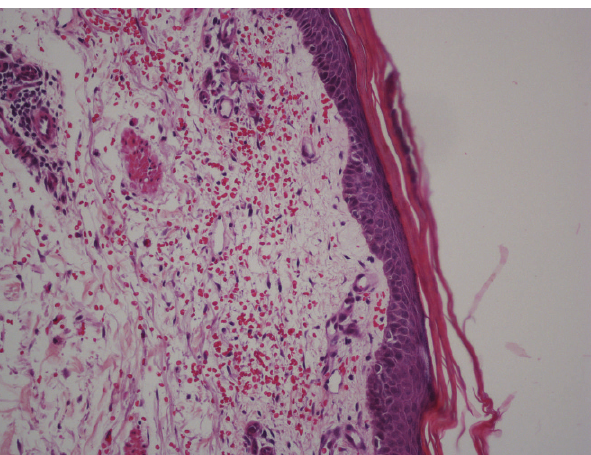
Figure 2 - Scurvy: red cell extravasations around vessels in the upper dermis, dermal and epidermal atrophy and parakeratosis, and mild chronic